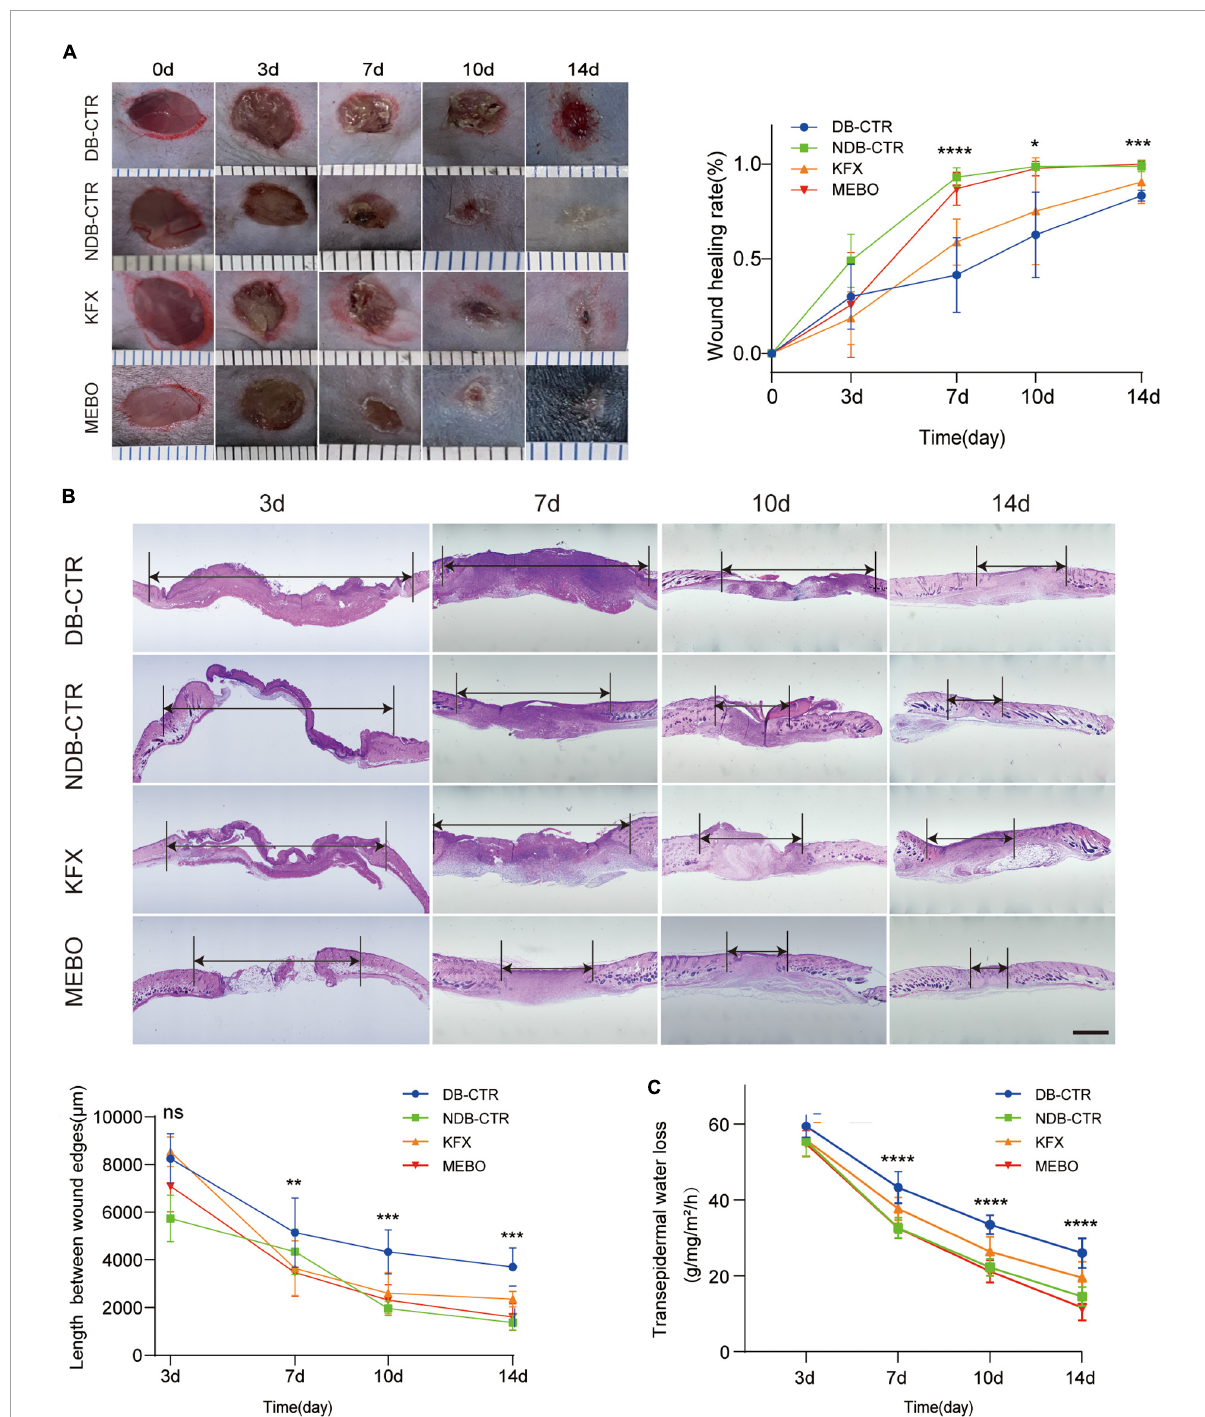
FIGURE1 MEBO promoted diabetic wound healing in mice. (A) The representative images of the appearance of wound healing over time in each group. The scale is 1,000 µ m. The wound healing rate of mice in each group was quantitatively analyzed by ImageJ software. (B) Representative images of HE staining of the wound skin at 3,7,10, and 14 day. The length between wound edges were measured by NIS-Elements Viewer. The scale is 1,000 µ m. (C) Transepidermal water loss rates were measured with TM300. Diabetic Control (DB–CTR): Diabetic mice were treated with physiological saline on the wound surface. Non-diabetic Control (NDB–CTR): Normal mice were treated with physiological saline on the wound surface. KFX: Diabetic mice were treated with KFX on the wound surface. MEBO: Diabetic mice were treated with MEBO on the wound surface. At least 6 independent sections were chosen at each time for each group. All Data are shown as mean ± SD, ns P > 0.05, * P < 0.05, ** P < 0.01, *** P < 0.001, **** P <